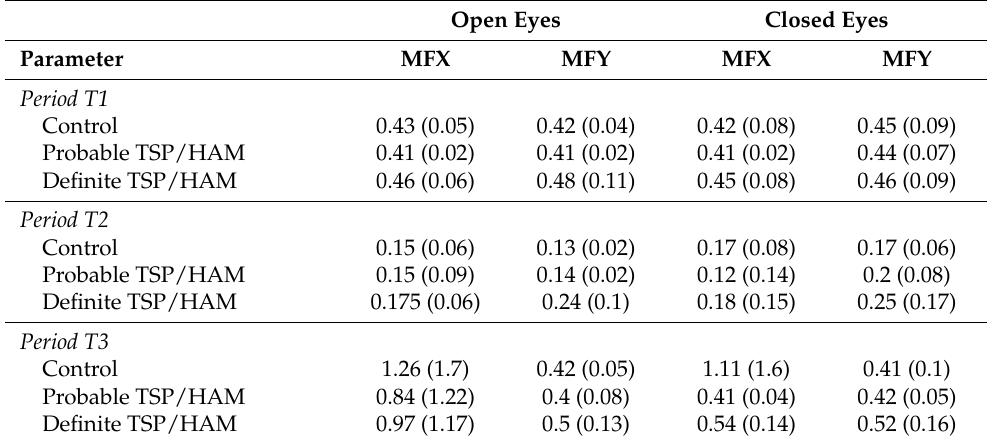
Table 5. Mean (standard deviation) of the global parameters measured in the frequency domain. Open Eyes Closed